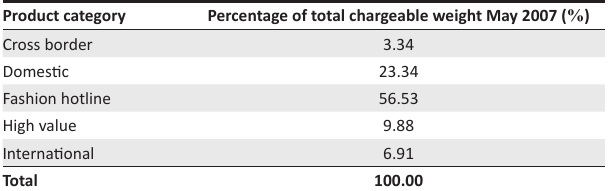
FIGURE 3: Transport index trend line.